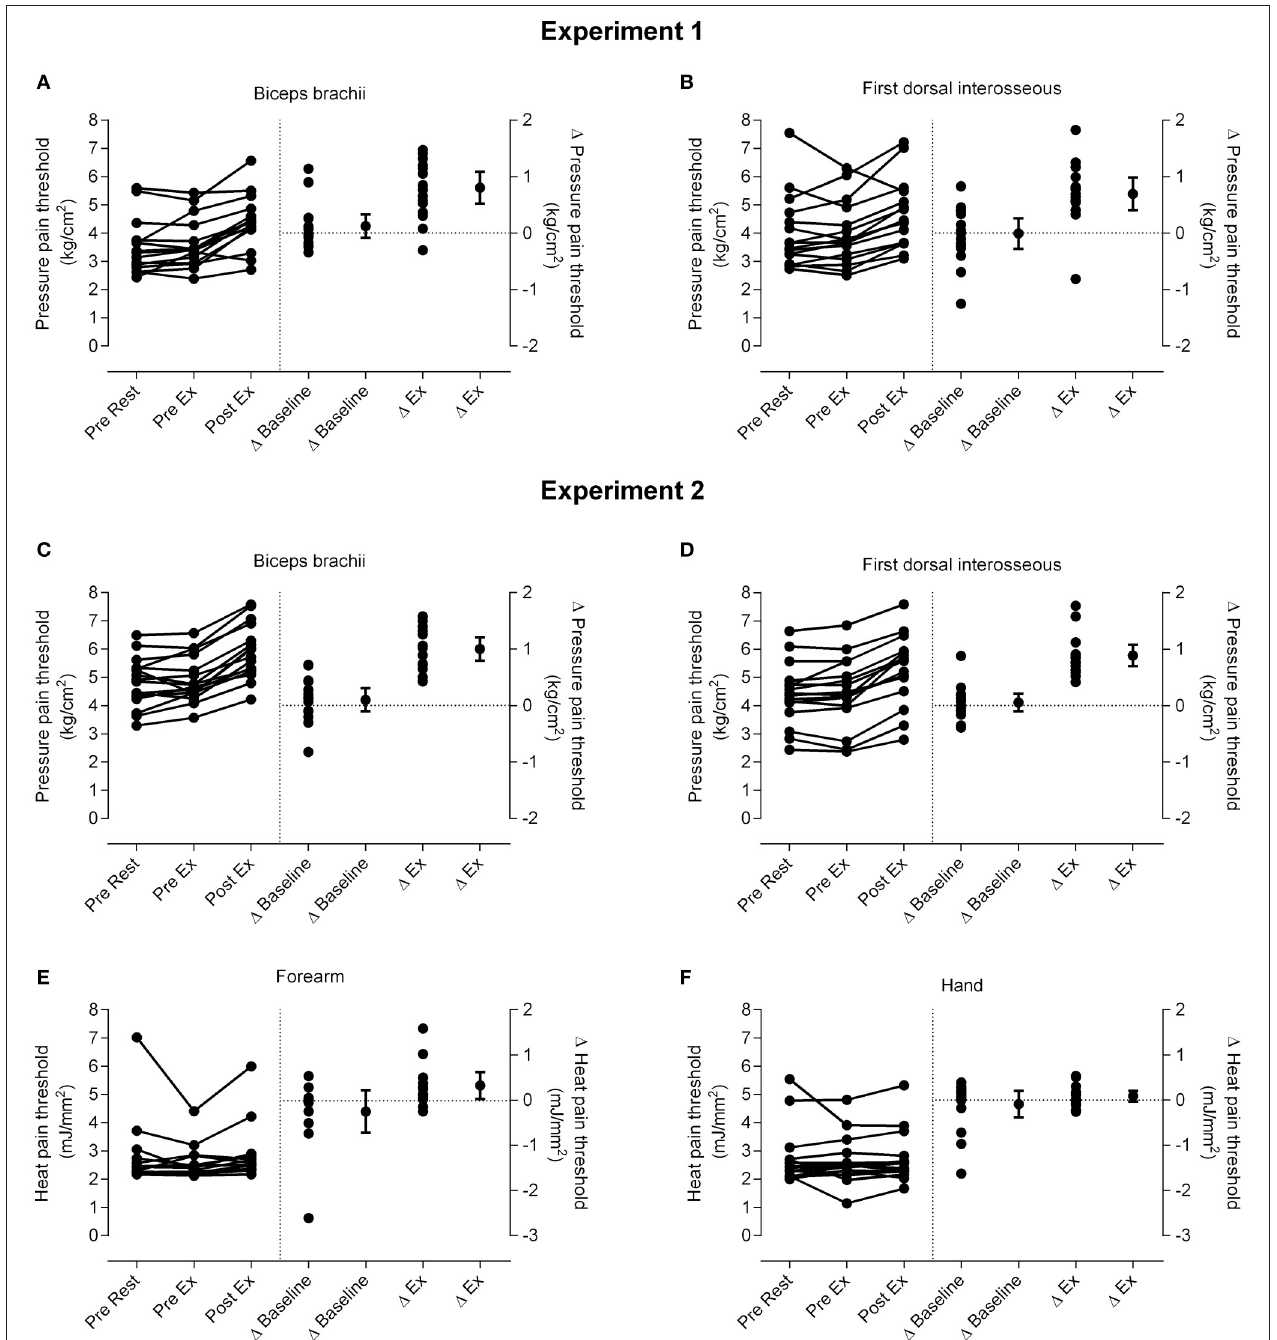
FIGURE 2 | Changes in pain threshold. Individual data for pressure pain thresholds (PPTs; left side of vertical dotted line) and the differences in PPTs for individual participants and the group (mean and 95% confidence interval; right side of vertical line) at m. biceps brachii in Experiment 1 (A) and Experiment 2 (C) and m. first dorsal interosseous in Experiment 1 (B) and Experiment 2 (D) . Individual data for heat pain thresholds (HPTs; left side of vertical dotted line) and the differences in HPTs for individual participants and the group (mean and 95% confidence interval; right side of vertical line) at the forearm (E) and hand (F) in Experiment 2 are also shown. 1 baseline is the difference between the pre rest and pre exercise measures and 1 ex (exercise) is the difference between the pre exercise and post exercise measures. Data to the left of the vertical dotted line are plotted against the left-hand y-axis and data to the right of the vertical dotted line are plotted against the right-hand